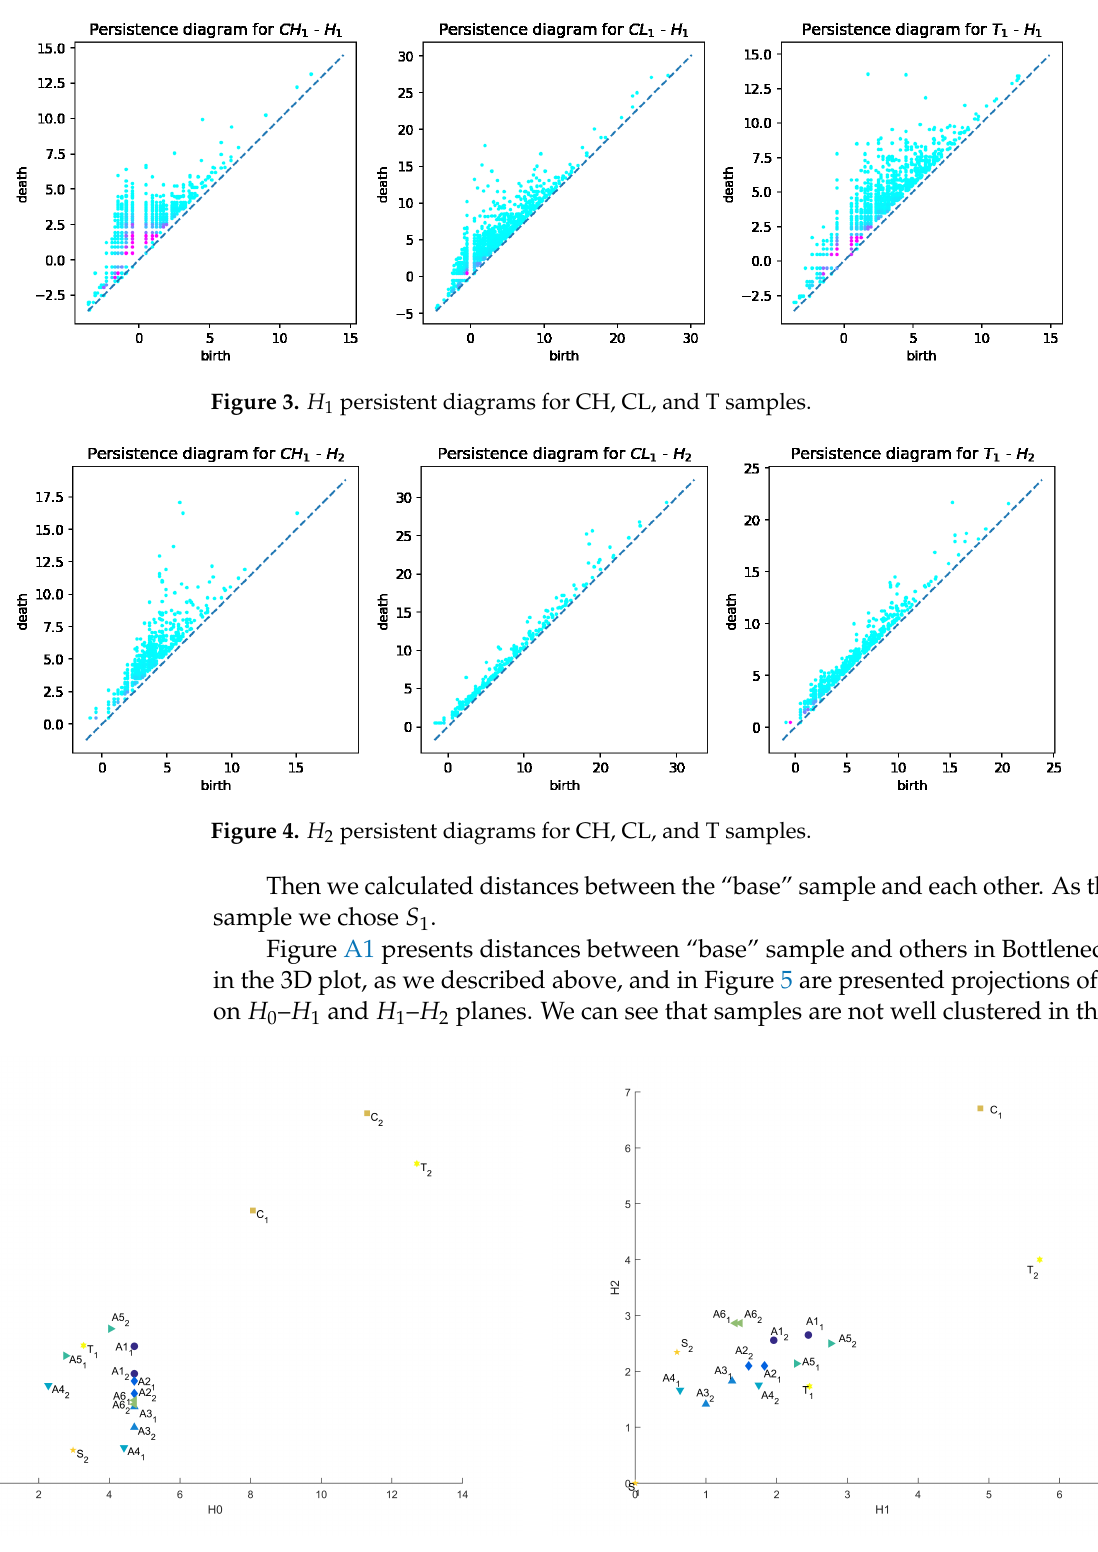
Figure 5. Common distances in Bottleneck metric in H 0 – H 1 and H 1 – H 2